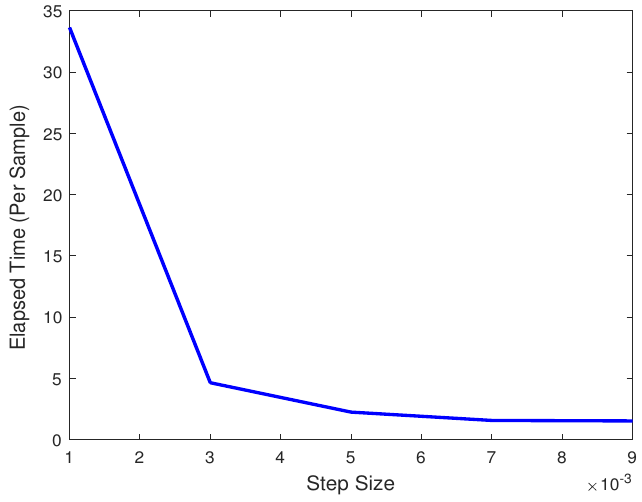
Figure 14. Plot of elapsed times per sample vs. Step